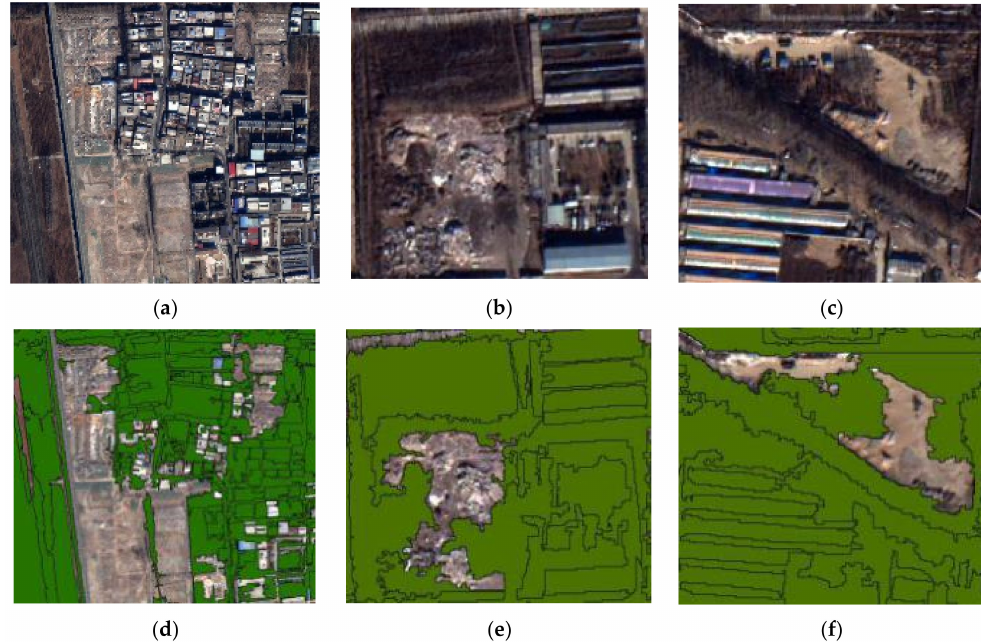
Figure 17. Classification results for the first layer structure: ( a – c ) the red band and the fifth band to separate vegetation, roads, and some buildings, ( d – f ) the areas classified as vegetation, roads, and some buildings.